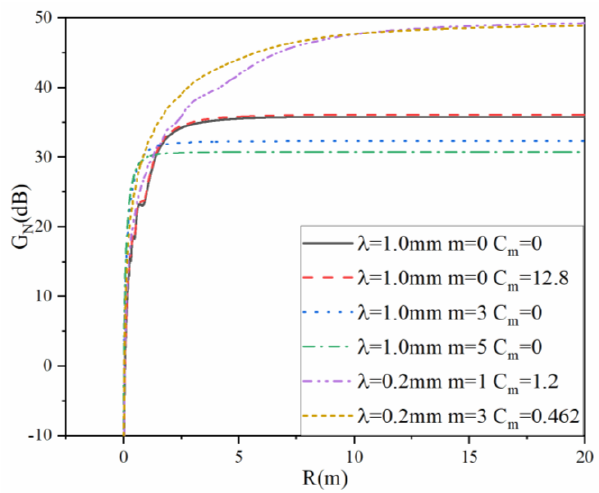
Figure 9. Near-field gain of transmitting and receiving antennas for the radar system with different aperture field distributions.